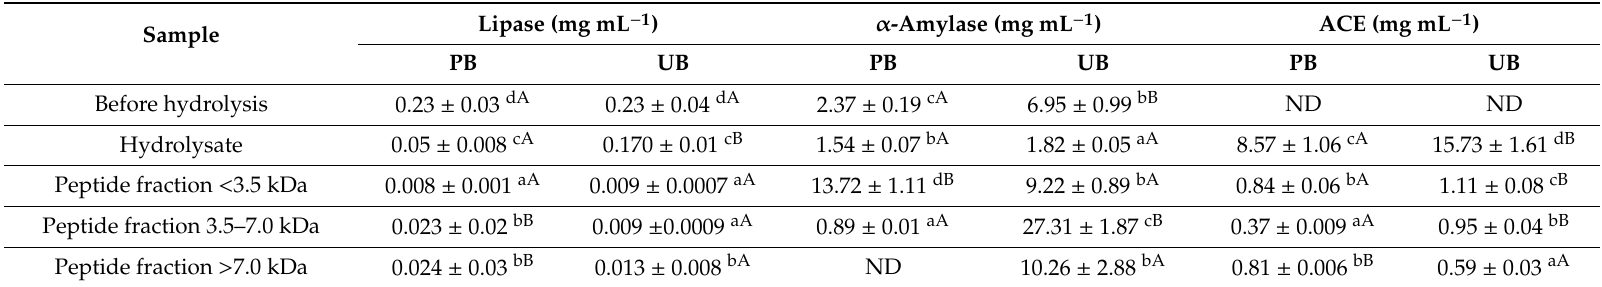
Table 4. Inhibition of enzymes involved in metabolic syndrome pathogenesis (IC 50